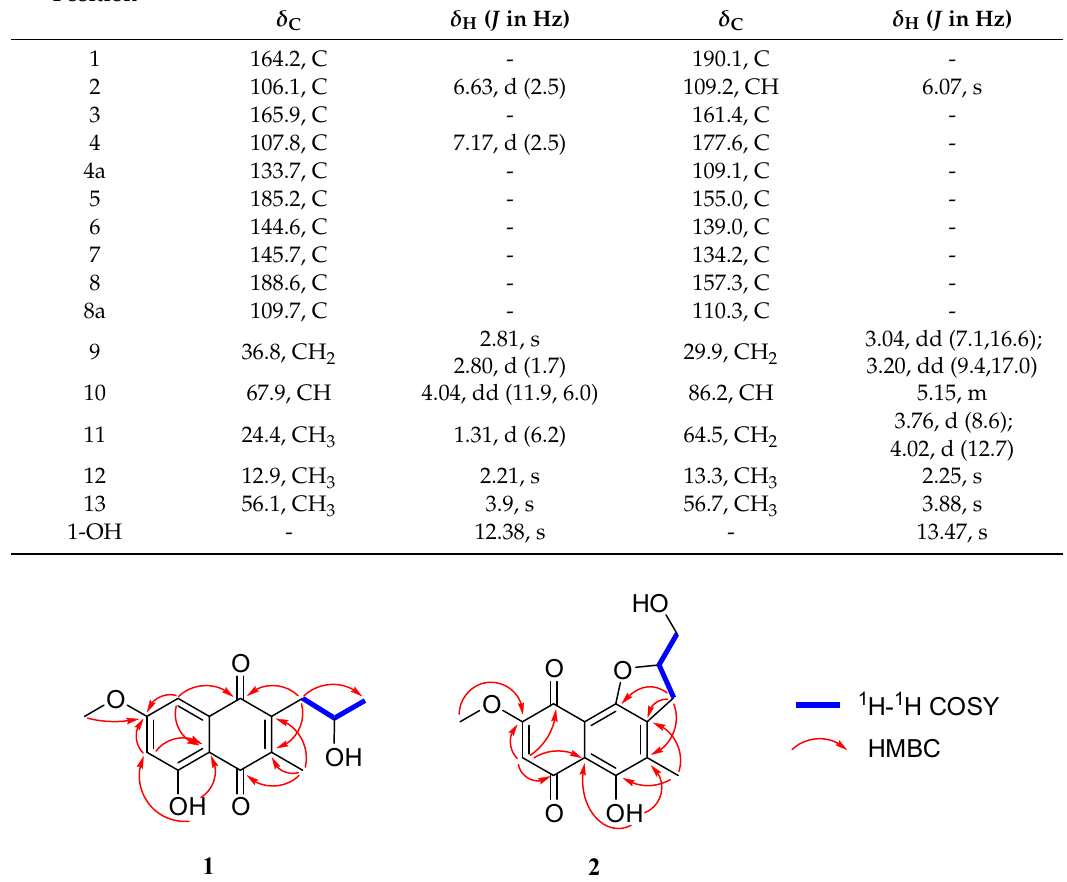
Figure 2. Key HMBC (red arrows) and COSY (blue bold lines) correlations of compounds 1 and 2.